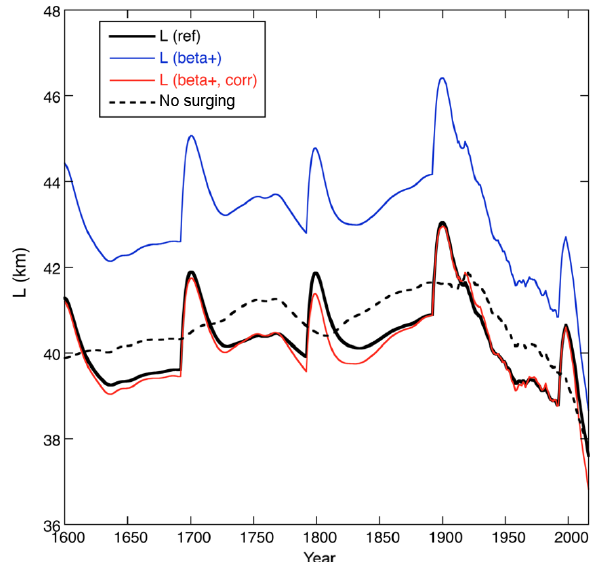
Figure 9. Sensitivity of glacier length to different values of the calv- ing parameter c . For a halved (red curve) or doubled (green curve) value of c , the model has been recalibrated by adjusting the ELA (values given in